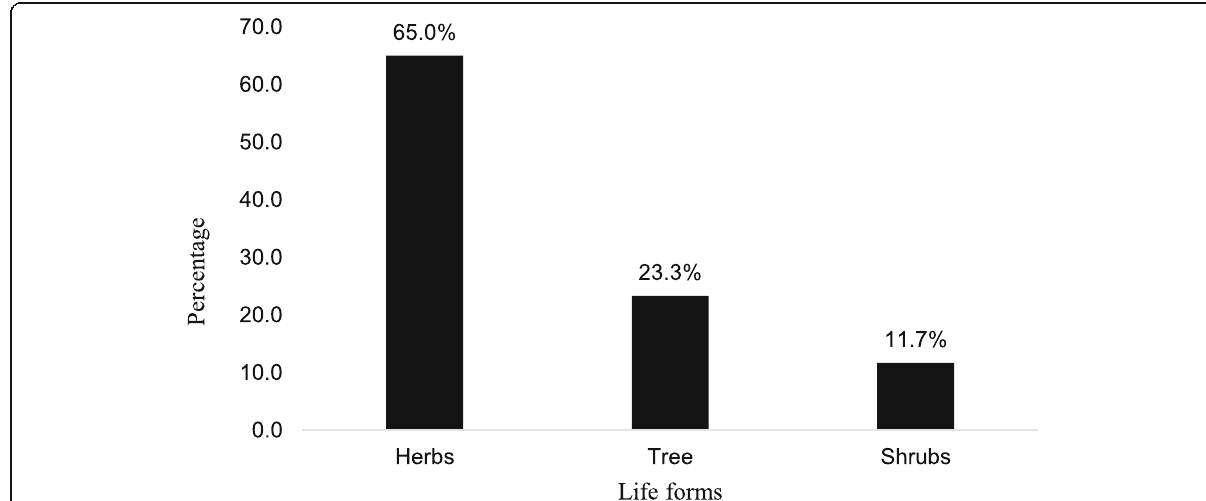
Fig. 2 Life forms of medicinal plant species used in the management of snakebites envenomation in Acholi, Teso and Karamoja sub-regions of